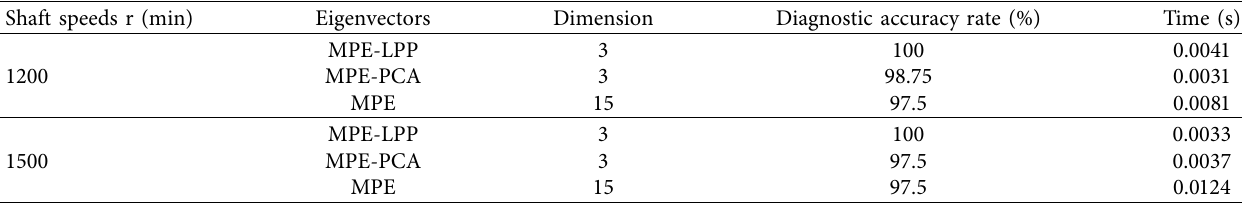
Figure 11: The 3D map at speed of 1,500r/min. (a) The 3D map of MPE-LPP. (b) The 3D map of MPE-PCA. (c) The 3D map of MPE. Table 3: Fault diagnosis result of spiral bevel gears at different